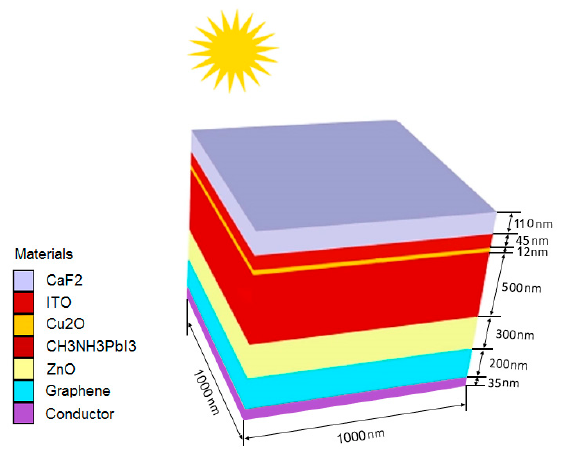
Figure 1. Physical structure of the inverted planar PSC.